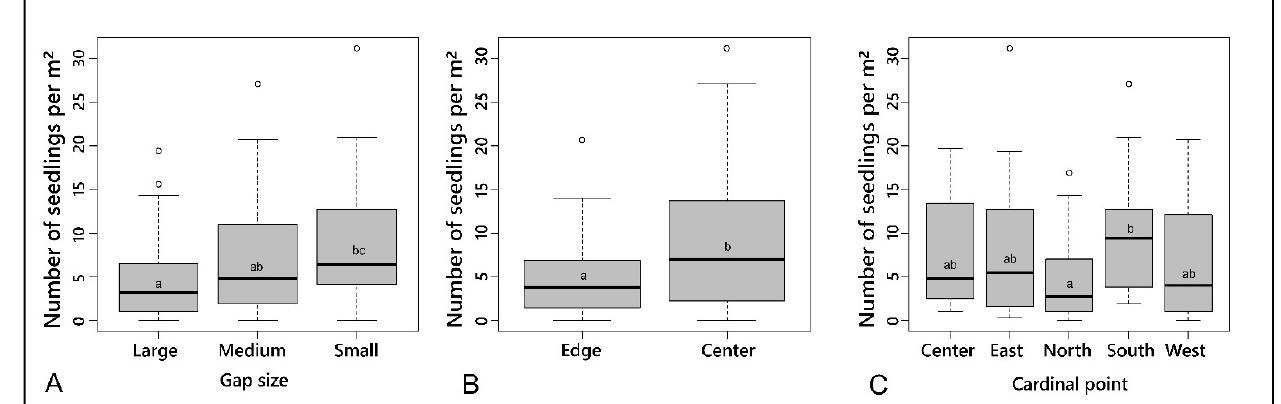
Figure 4. Number of seedlings per m 2 per gap-size ( A ), number of seedlings in the edge and in the center of gaps ( B ), in cardinal point ( C ). The box plots explanations are as in Figure 2, with the difference of the median values represented here by the heavy horizontal line. Boxes with different letters indicate significant differences in number of seedlings per m 2 ( p < 0.05).